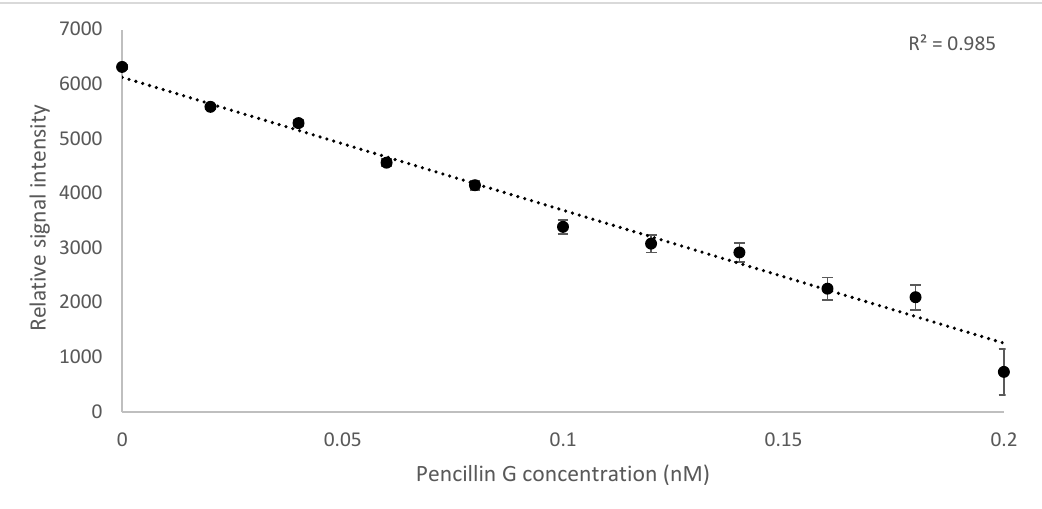
Figure 3. Penicillin quantification based on the inhibition of on-column Bocillin FL binding to PBP2x protein by the addition of gradient concentrations of the antibiotic (0–0.2 nM) to 0.2 nM of the protein. The curve shows the collinearity (R 2 = 0.985) between the antibiotic concentration and the fluorescence intensity of bounded Bocillin FL to the protein, measured by real-time PCR machine (excitation at wavelength 504 nm and emission at 511 nm).